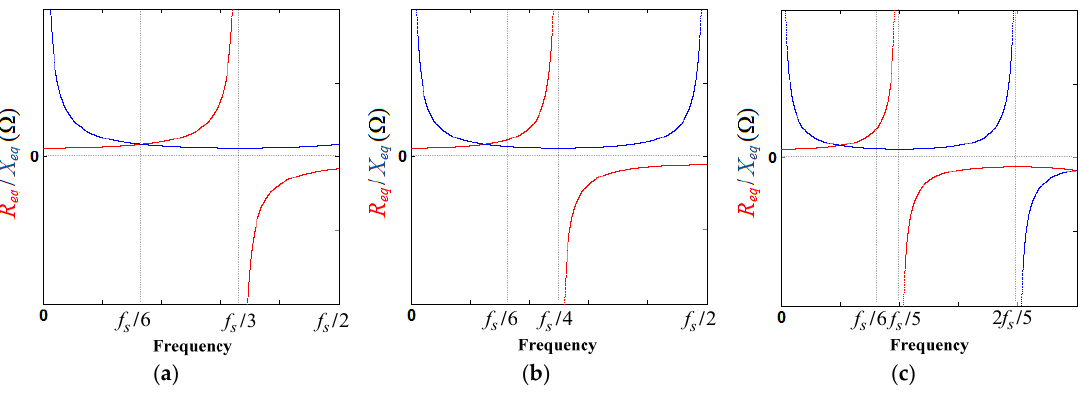
Figure 22. Curves of R eq and X eq as the function of frequency: ( a ) λ = 0.25; ( b ) λ = 0.5; and ( c ) λ = 0.75.